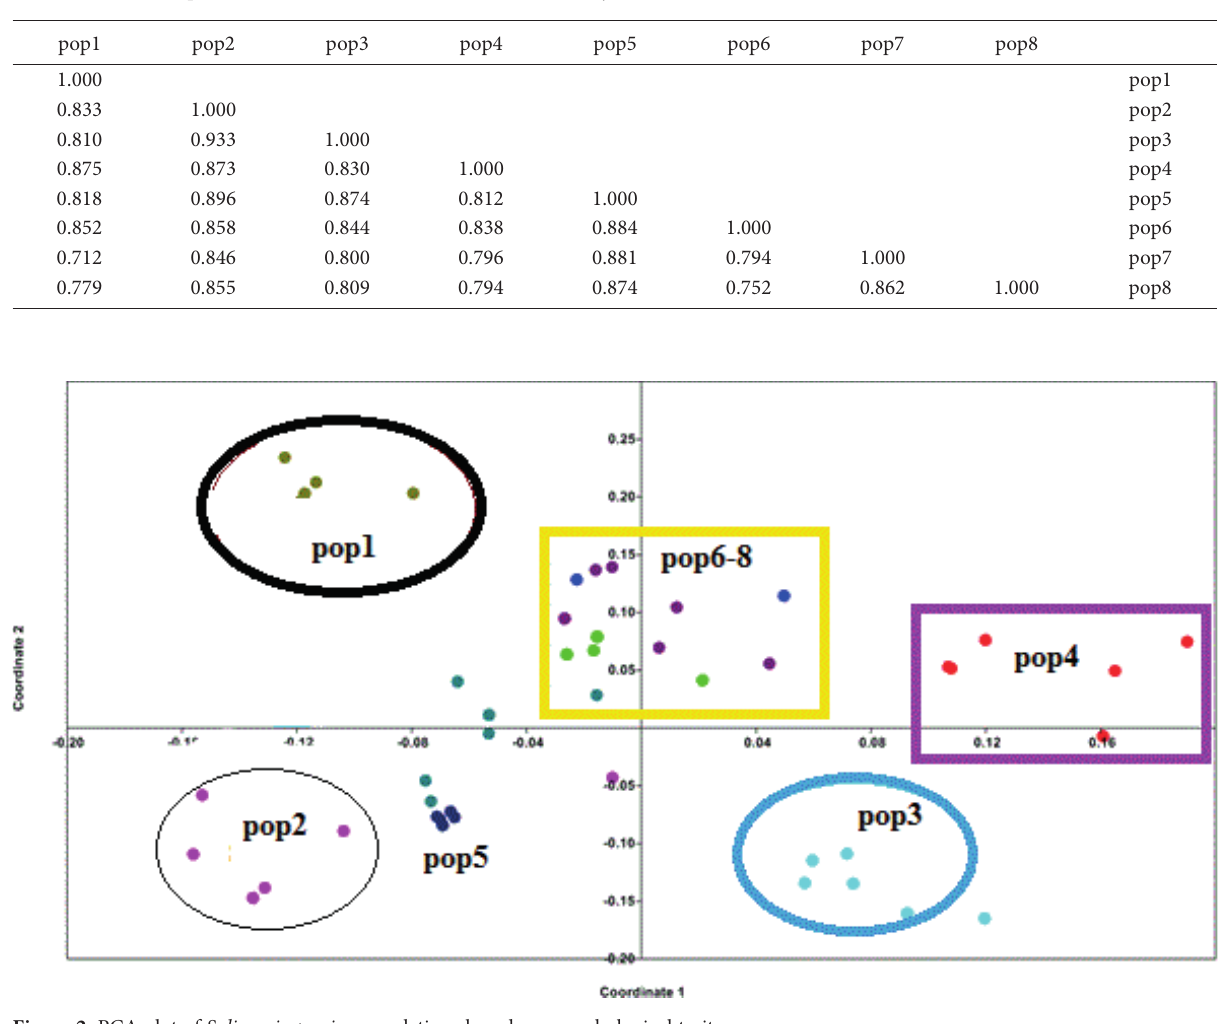
Figure 2. PCA plot of Salicornia persica populations based on morphological